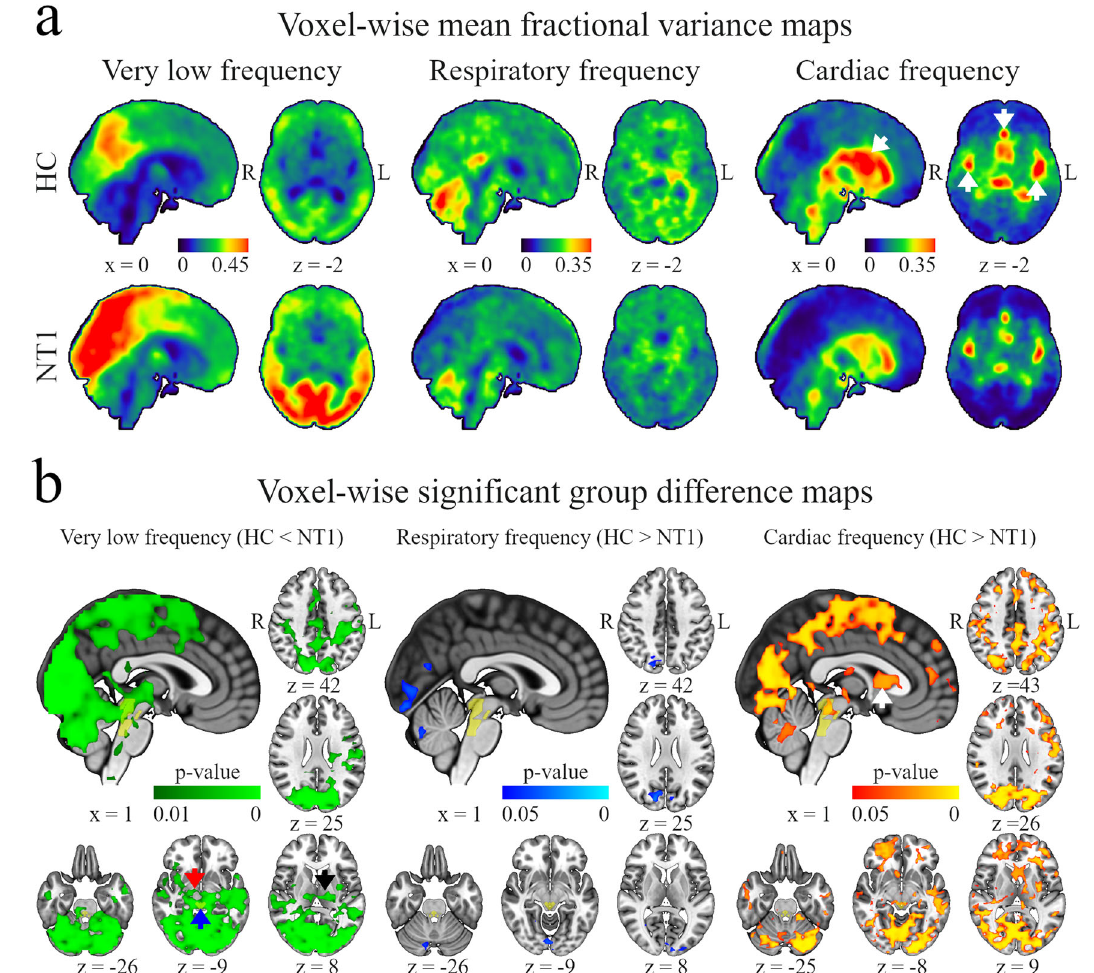
Fig. 3 Frequency-wise fractional variance results. a Voxel-wise mean fractional variance maps. Very low frequency- and respiratory-related fractional variance are most pronounced in the brain parenchyma, while cardiac-related fractional variance populates the ventricular system and large arteries. White arrows = anterior-, middle cerebral arteries, and ventricular system. Color bars represent a sliding scale of mean fractional variance values across all healthy controls (HC) and patients with narcolepsy type 1 (NT1), respectively. R right, L left, x displayed sagittal plane, z displayed axial plane b Voxel-wise signi fi cant group difference maps. Fractional variance results in very low frequency (HC < NT1, green area), respiratory-related (HC > NT1, blue area), and cardiac-related (HC > NT1, red area) pulsation frequencies overlap mostly in the posterior brain regions and ascending arousal network (AAN). White arrow = anterior corni of the lateral ventricles, black arrow = basal ganglia, blue arrow = aqueductus sylvii, red arrow = hypothalamus, yellow area = AAN. P values < 0.05 are signi fi cant, n = 22 HC vs. 22